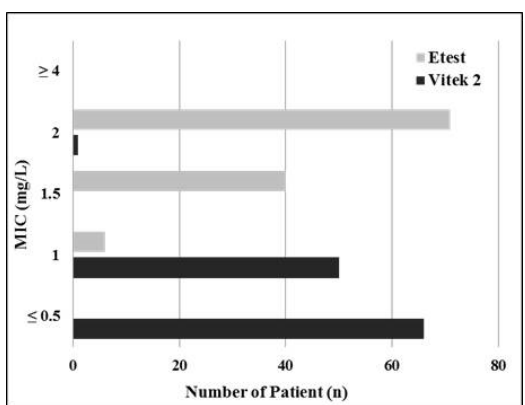
Figure 1. Vancomycin minimum inhibitory concentration (MIC) distribution comparison between Vitek 2 method and E ‐ test method. Abbreviations: MIC, minimum inhibitory concentration.